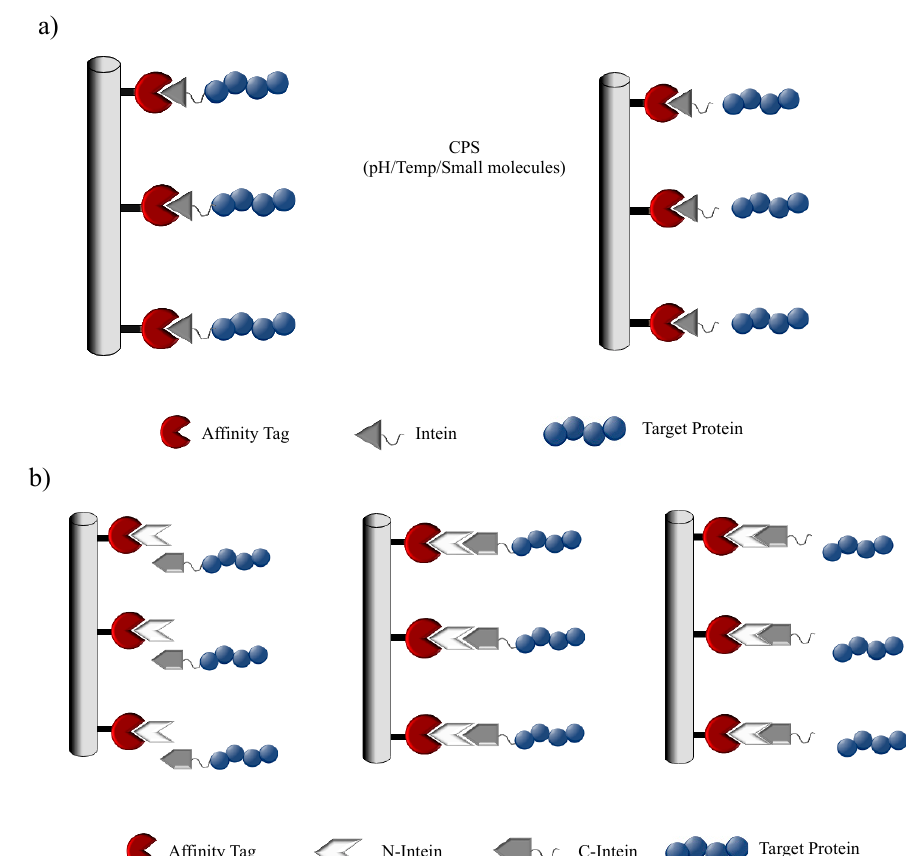
Figure 7. Protein purification system using intein-mediated self-cleaving tag. ( a ) The IMPACT-CN system includes an affinity tag (red) within the intein (grey) and the intein is tagged with a target protein (blue spheres) at C terminal site. ( b ) Schematic representation of split-intein based purification system, where the N-terminal intein is tagged with affinity tag whereas the C-terminal intein is fused with the target protein. The N- and C-intein ligates to form a functional intein segment. Addition of thiol, temperature (Temp) and/or pH changes induce cleavage in the inteins shown above results in isolation of target protein.